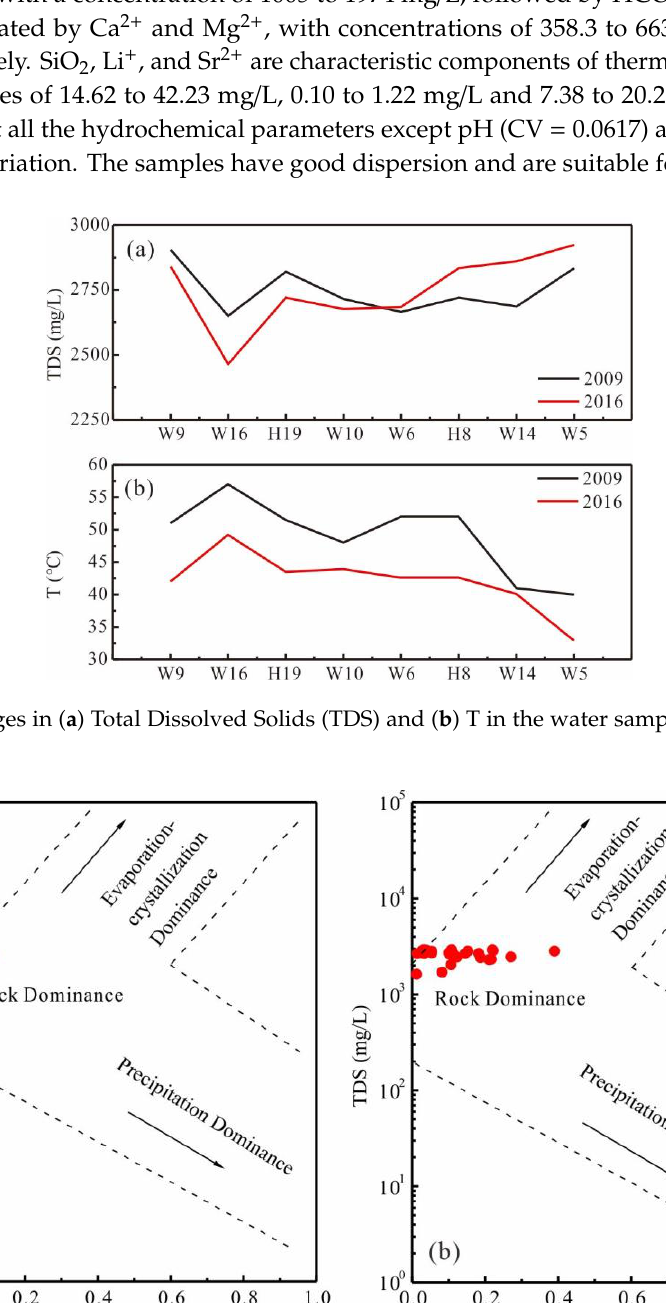
Figure 5. Gibbs diagram of thermal groundwater in the study area: ( a) TDS vs. Na + /(Na + + Ca 2+ ), ( b) TDS vs. Cl − /(Cl − + HCO 3− ).